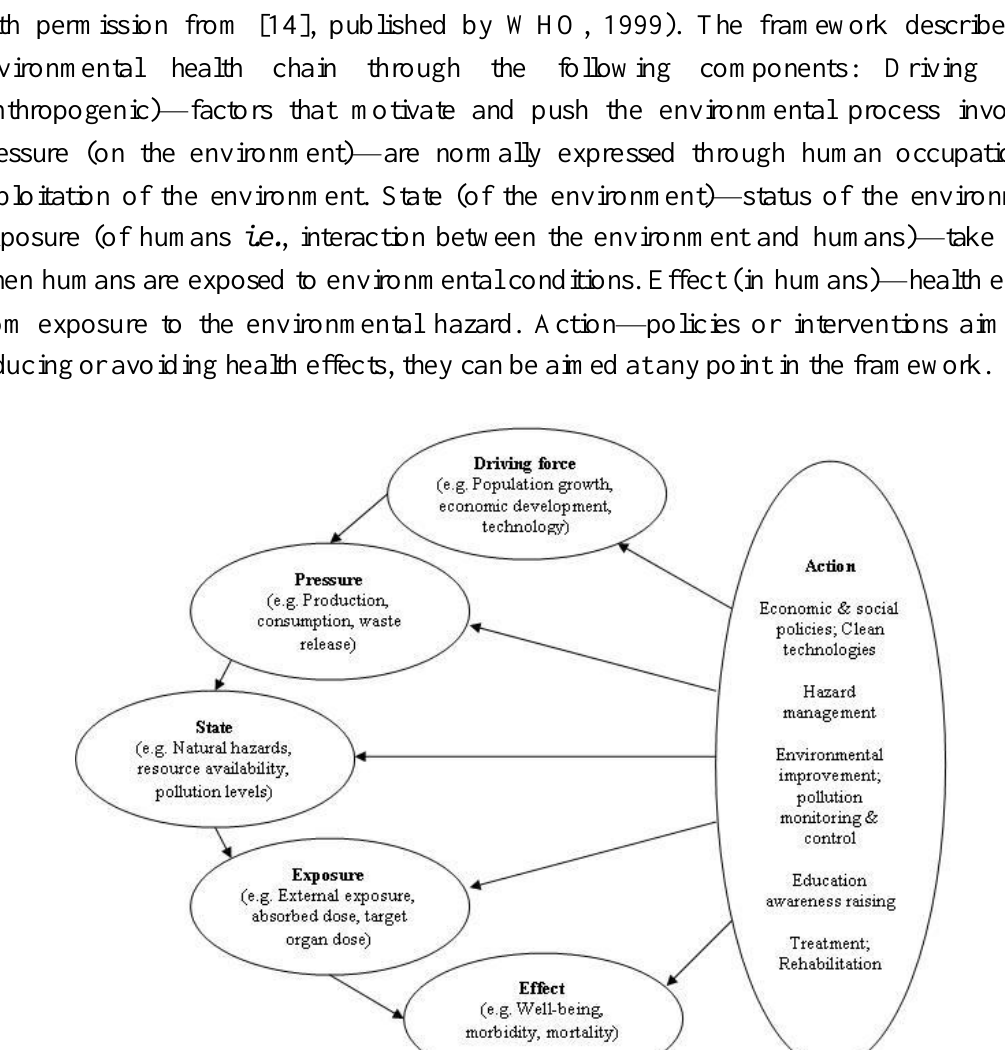
Figure 4. Driving force-Pressure-State-Exposure-Effect-Action framework